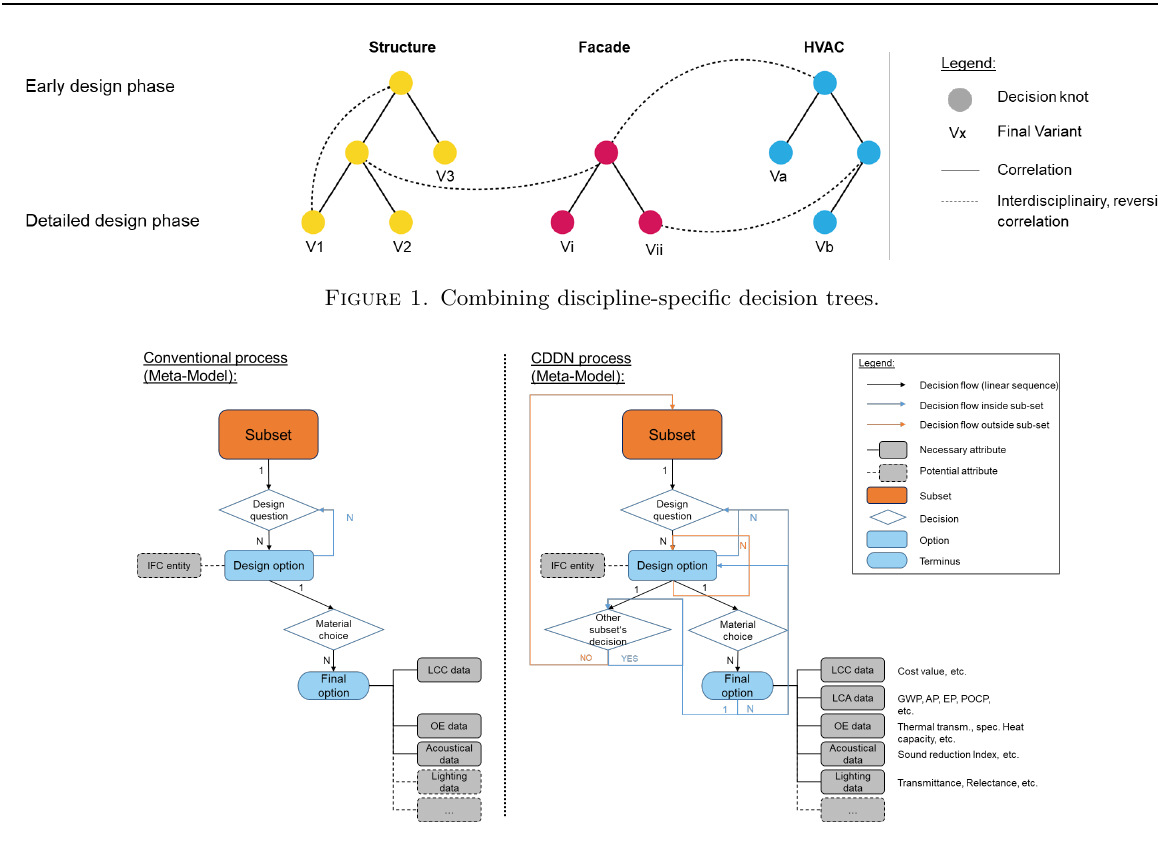
Figure 2. Meta-models of conventional and